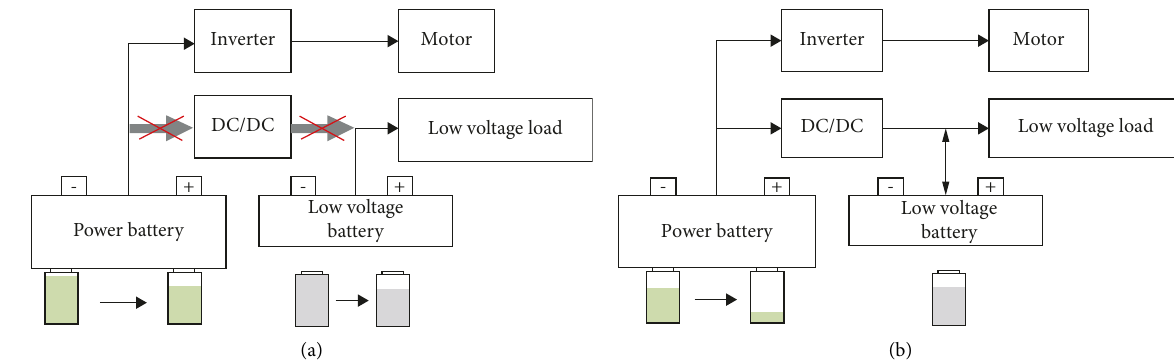
Figure 7: Energy management of electric drive conditions. (a) Energy management under sufficient power of the low-voltage battery. (b) Energy management under power balance of the low-voltage